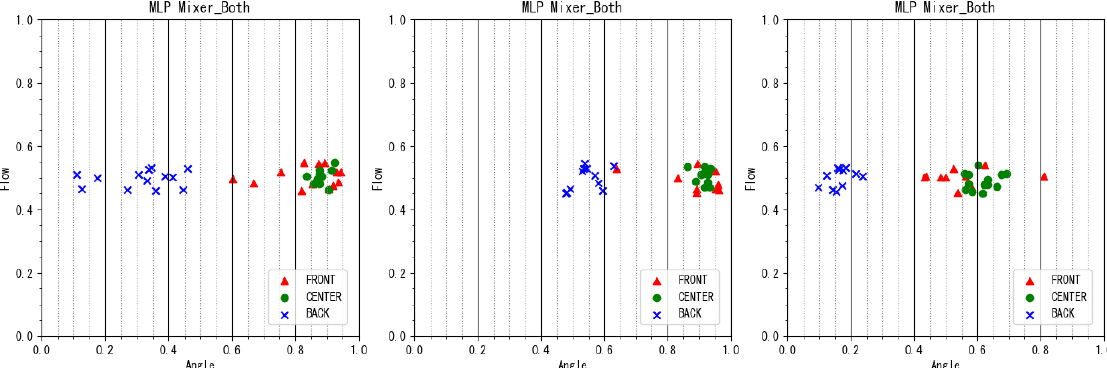
Figure 11. Example of failure of angle estimation by the proposed